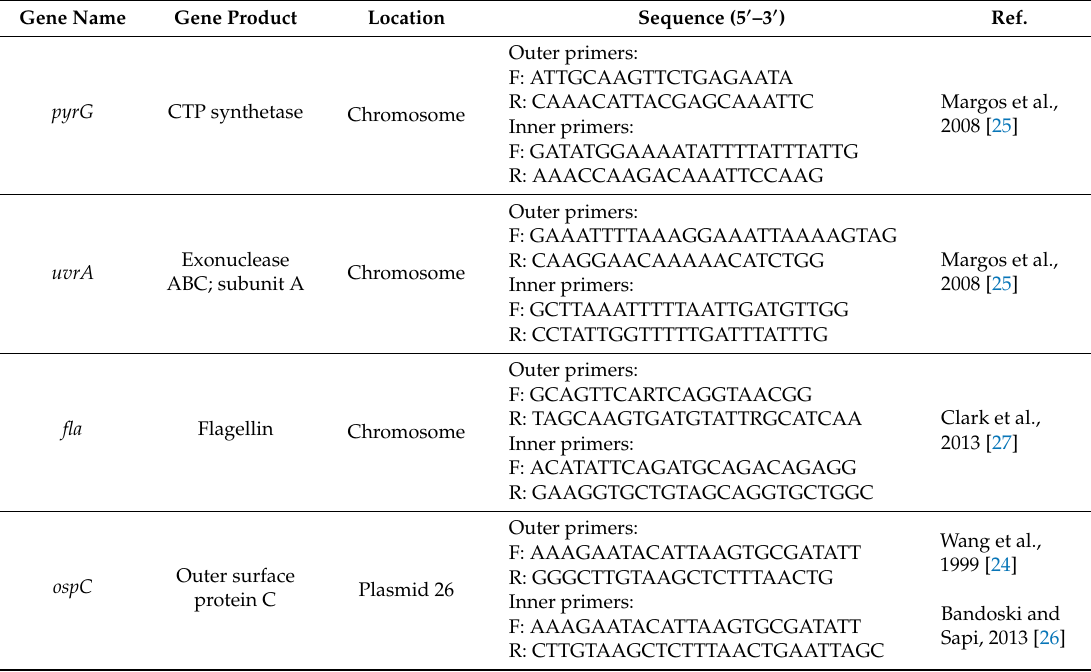
Table 1. PCR primers for Borrelia burgdorferi (Bb).